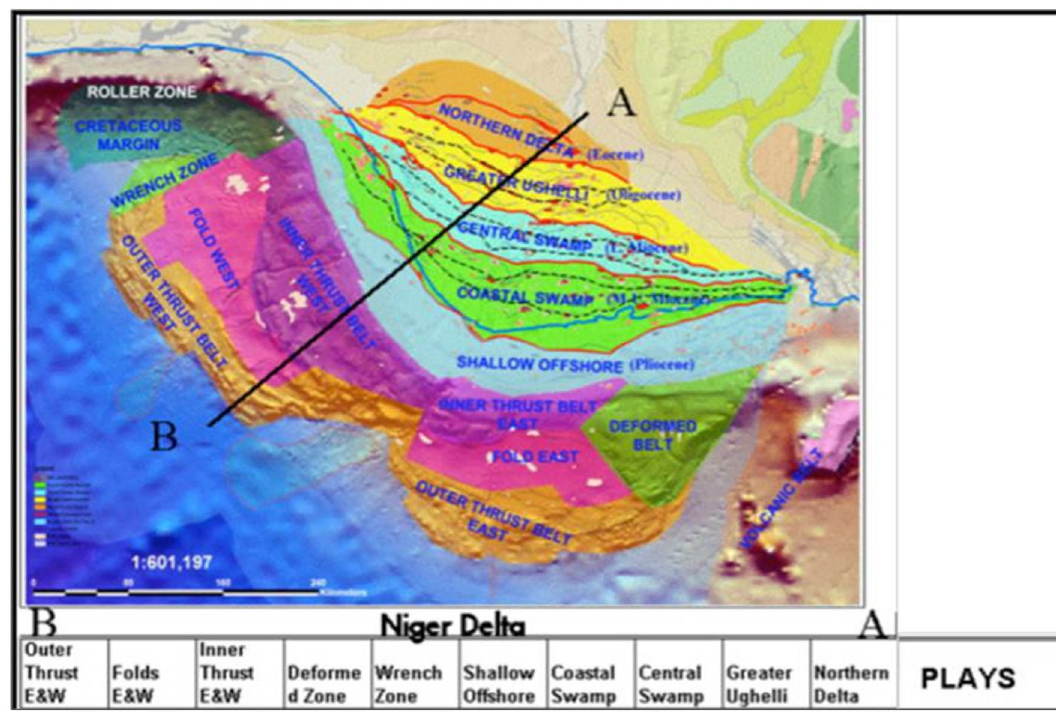
Fig. 2 The Niger delta depobelts (modified from Ejedawe